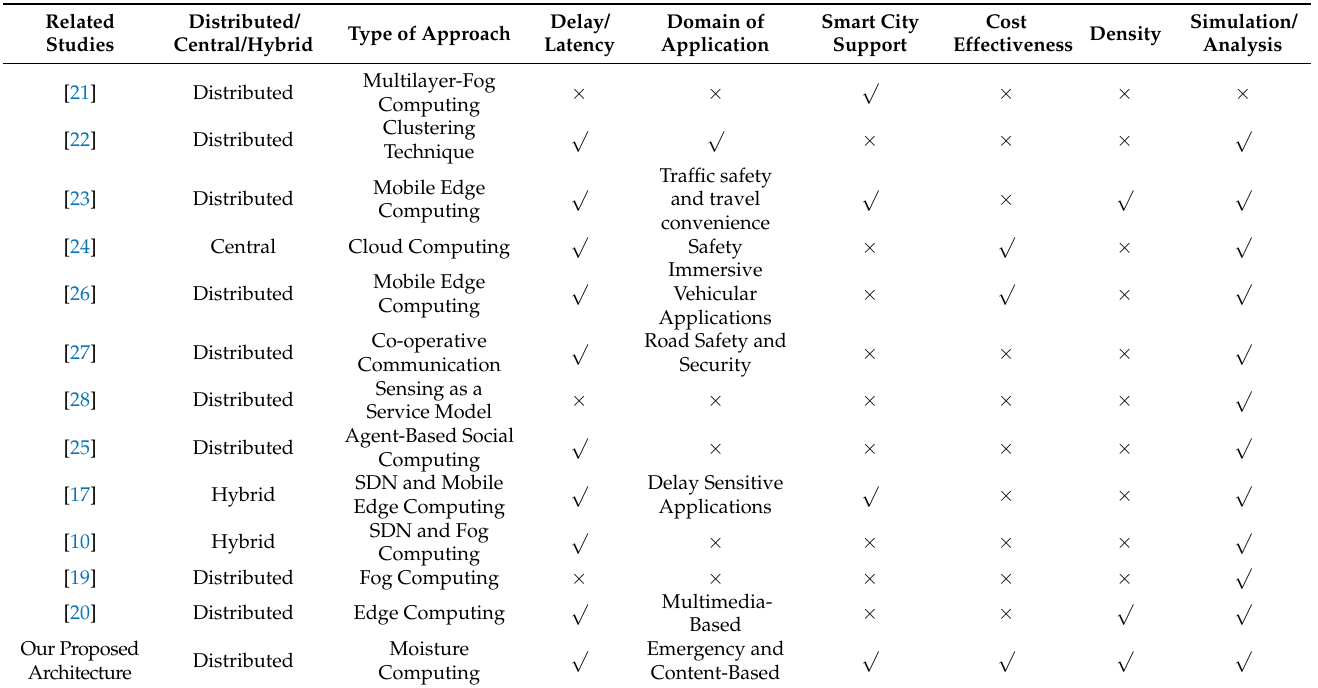
Table 1. Comparison of our proposed architecture with the existing